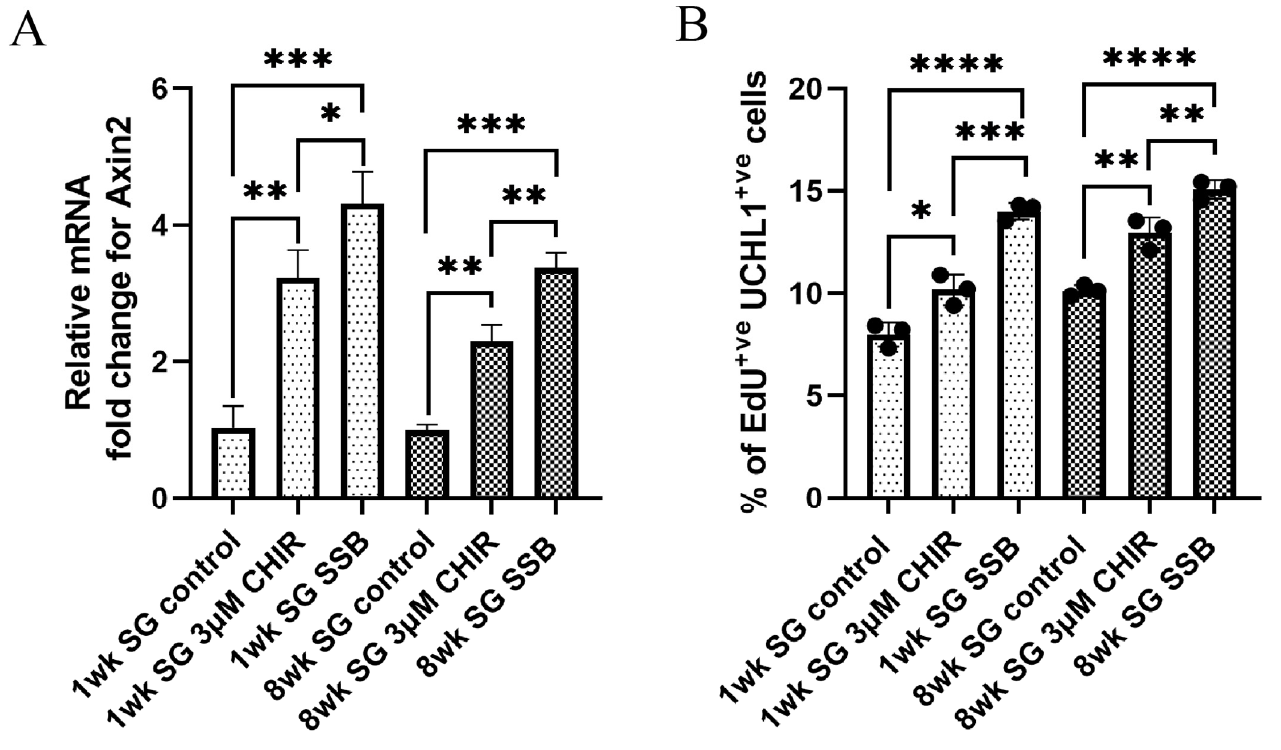
Figure 4. Activation of Wnt/ β -catenin pathway with CHIR 99021 in static culture does not fully mimic the effects of stirred suspension bioreactor culture: ( A ) relative mRNA fold change of Axin2 for 1- and 8-week-old spermatogonia (SG); ( B ) percentage of proliferating 1- and 8-week-old spermatogonia (SG). n = 3, mean ± SD. p > 0.05 (ns), * p ≤ 0.05, ** p ≤ 0.01, *** p ≤ 0.001, **** p ≤ 0.0001.